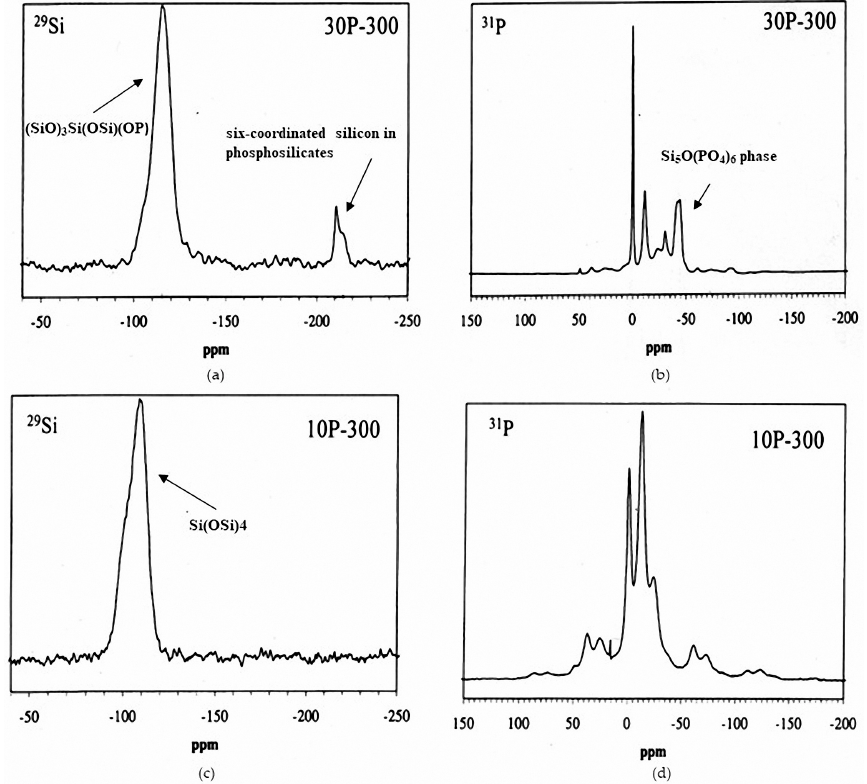
Figure 6. 29 Si and 31 P MAS-NMR spectra of the gels heat treated at 300 °C containing 30 mol % P 2 O 5 (30P-300) and 10 mol % P 2 O 5 (10P-300): ( a ) 29 Si of 30P-300; ( b ) 31 P of 30P-300; ( c ) 29 Si of 10P-300; ( d ) 31 P of 10P-300. Adapted with permission from [73]; Copyright 2003 Copyright The Royal Society of Chemistry.